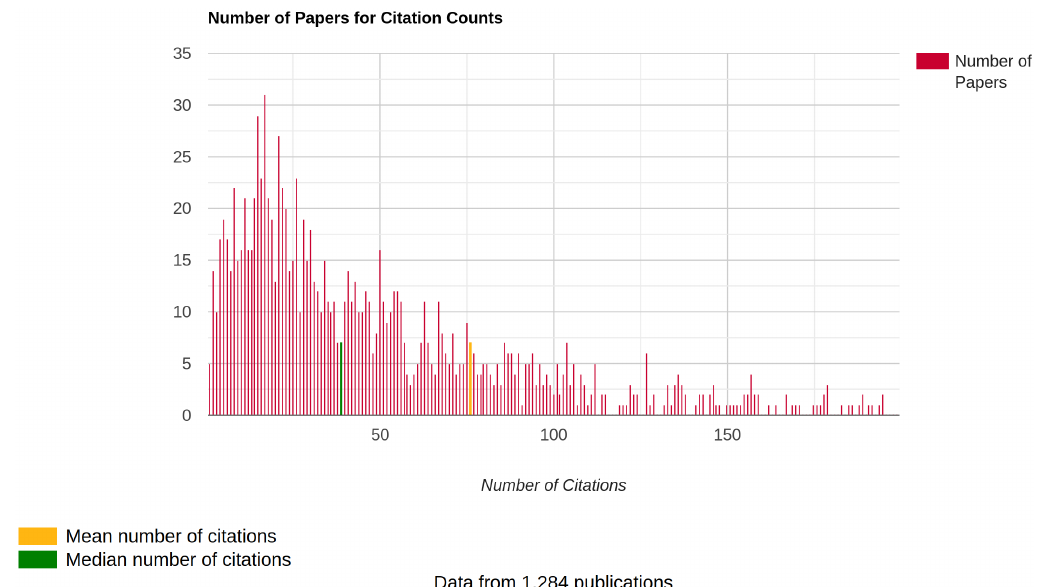
Figure 3. Citation count profile of ALSPAC publications as of 15/1/2021. The x-axis is truncated at 200 citations as there are a small number of publications disparately spread above this.